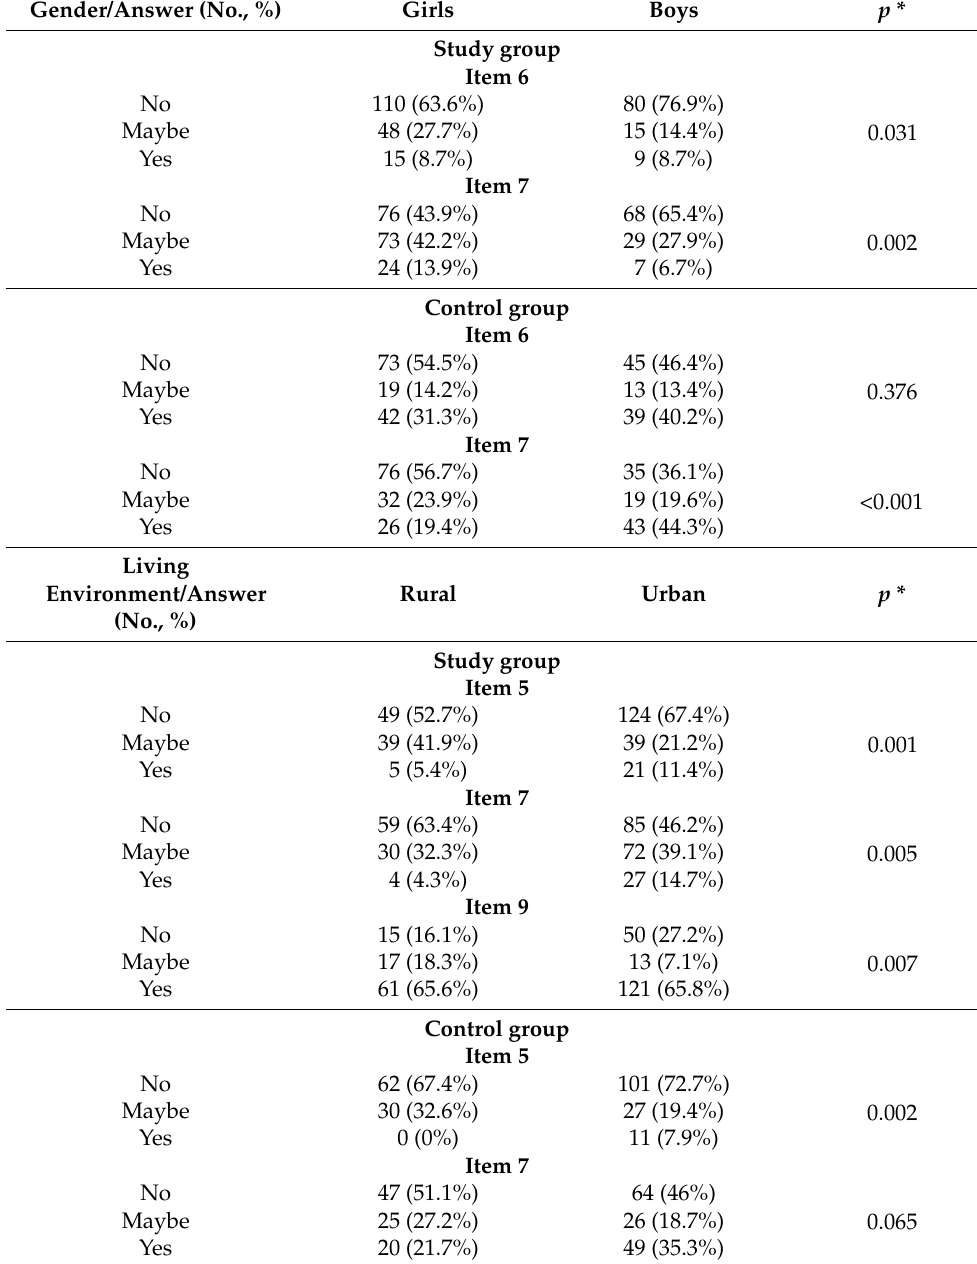
Table 5. Patients’ distribution according to gender, living environment, and answers provided for different items.